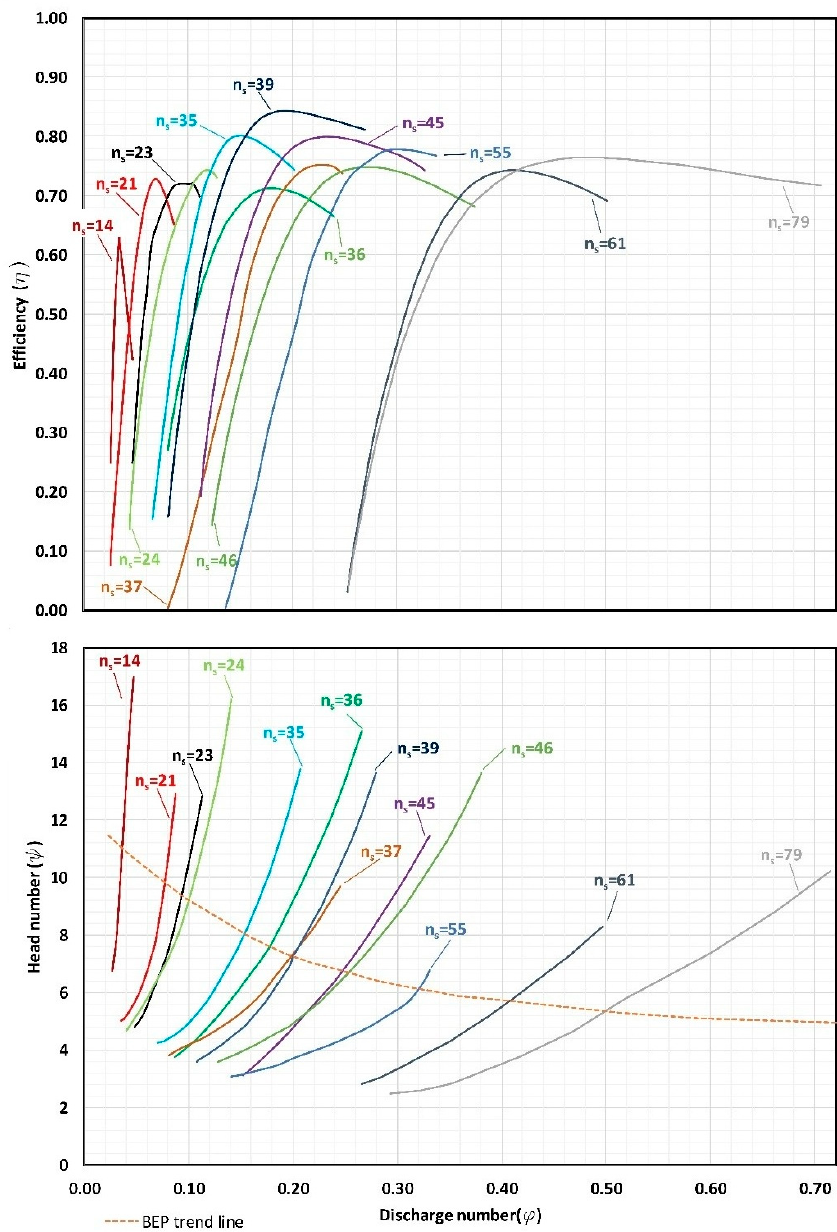
Figure 2. Characteristic curves based on experimental tests and affinity laws [35,37,38].